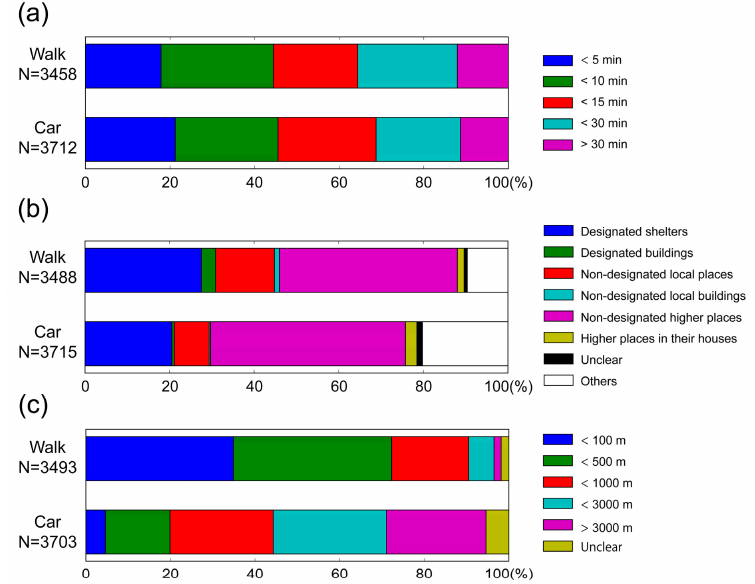
Figure 7. Differences in evacuation metrics based on the evacuation mode: ( a ) evacuation departure time, ( b ) evacuation destination, and ( c ) evacuation